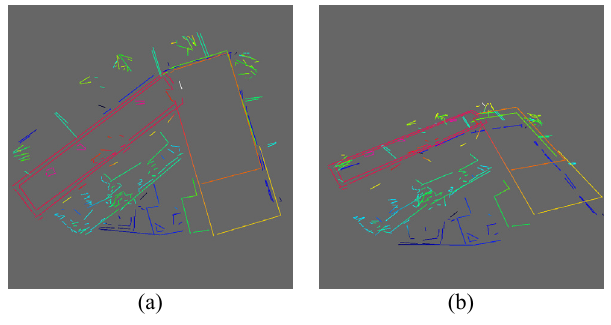
Figure 9. The 3D structure lines for Case II in (a) the first view and (b) the second view